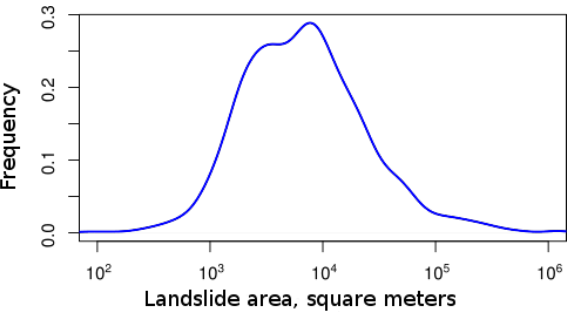
Figure 7. Size-frequency distribution of automatically detected landslides in